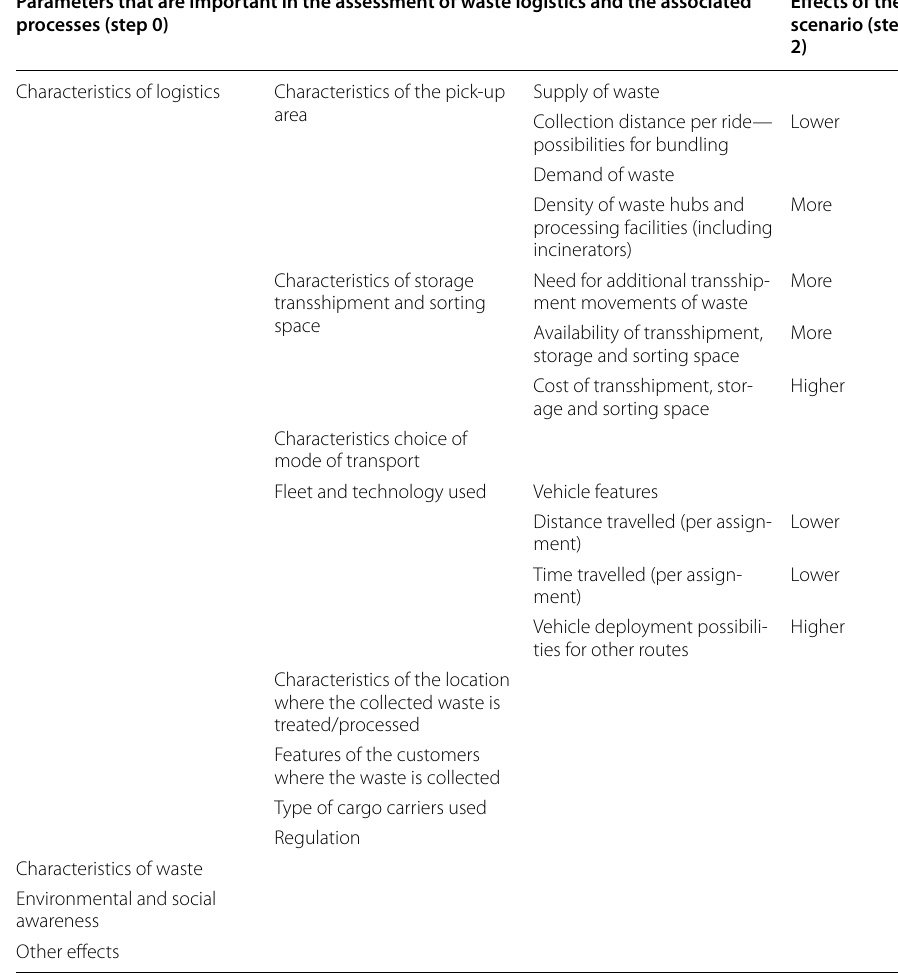
Table 7 Results step 3 case 3 (modal shift over water) Parameters that are important in the assessment of waste logistics and the associated processes (step